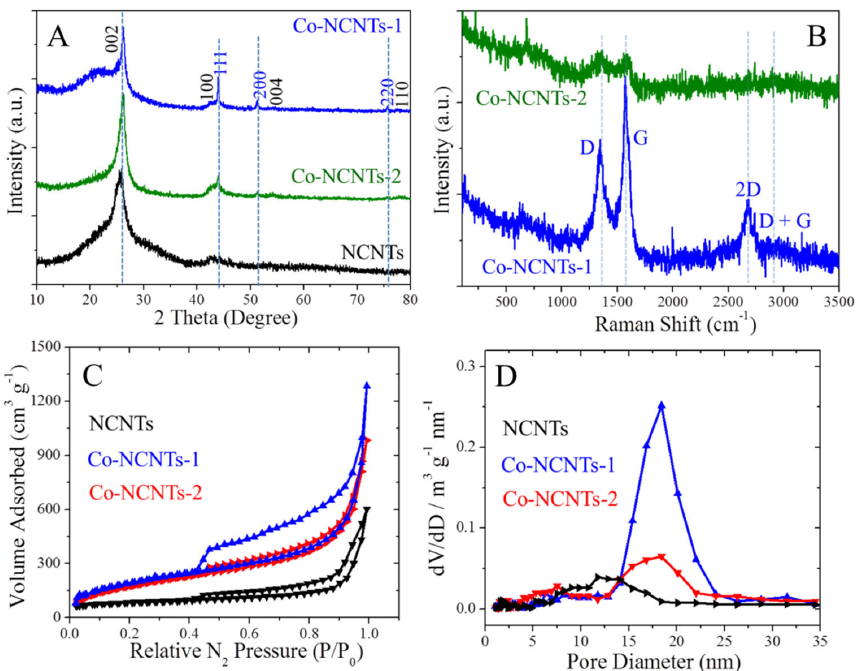
trum of Co@NCNsT ‐ 1 (Figure 4A, blue line) indicated that the Co nanoparticles were wrapped on the surface walls of the NCNT materials.